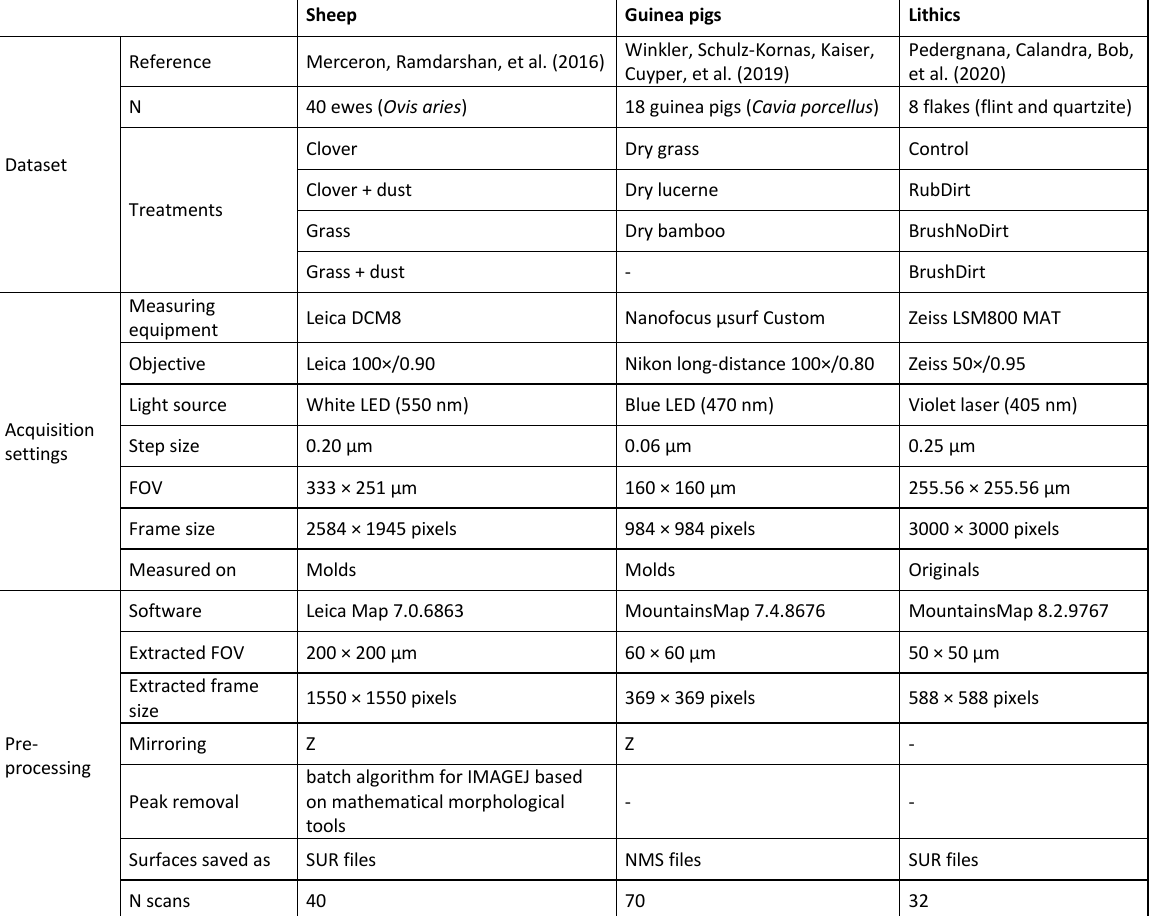
Table 1. Overview of the three published datasets re-analyzed. FOV = field of view, N = sample